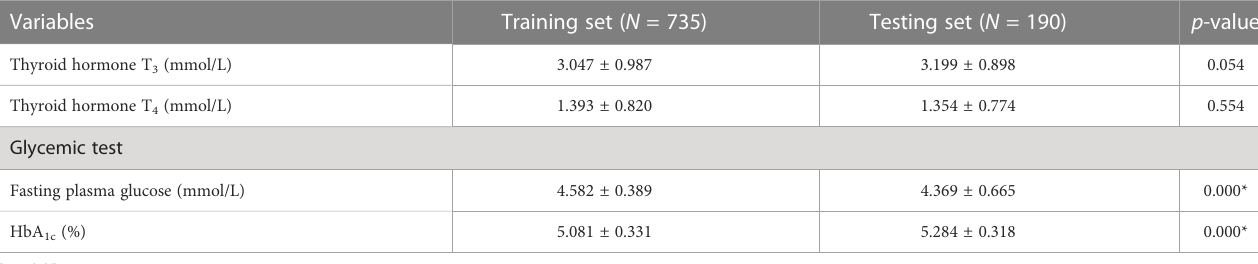
TABLE 3 Four predictors included in the model using stepwise LR in the training set. Variable b p -value